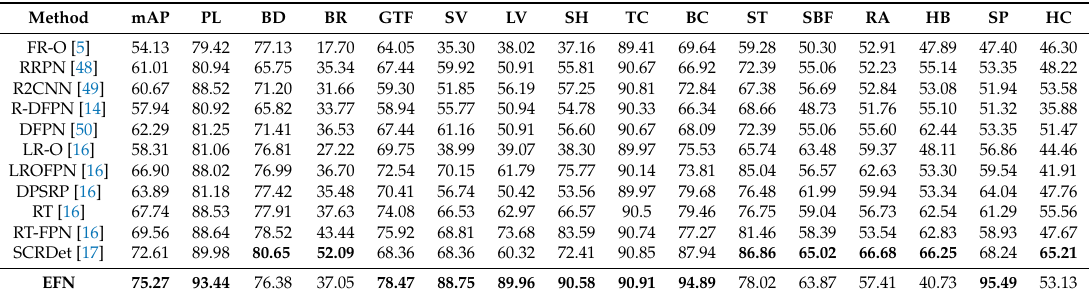
Table 1. Comparison with the state-of-the-art methods on DOTA1.0. The short names for categories are defined as: PL, Plane; BD, Baseball diamond; BR, Bridge; GTF, Ground field track; SV, Small vehicle; LV, Large vehicle; SH, Ship; TC, Tennis court; BC, Basketball court; ST, Storage tank; SBF, Soccer-ball field; RA, Roundabout; HB, Harbor; SP, Swimming pool; and HC, Helicopter.